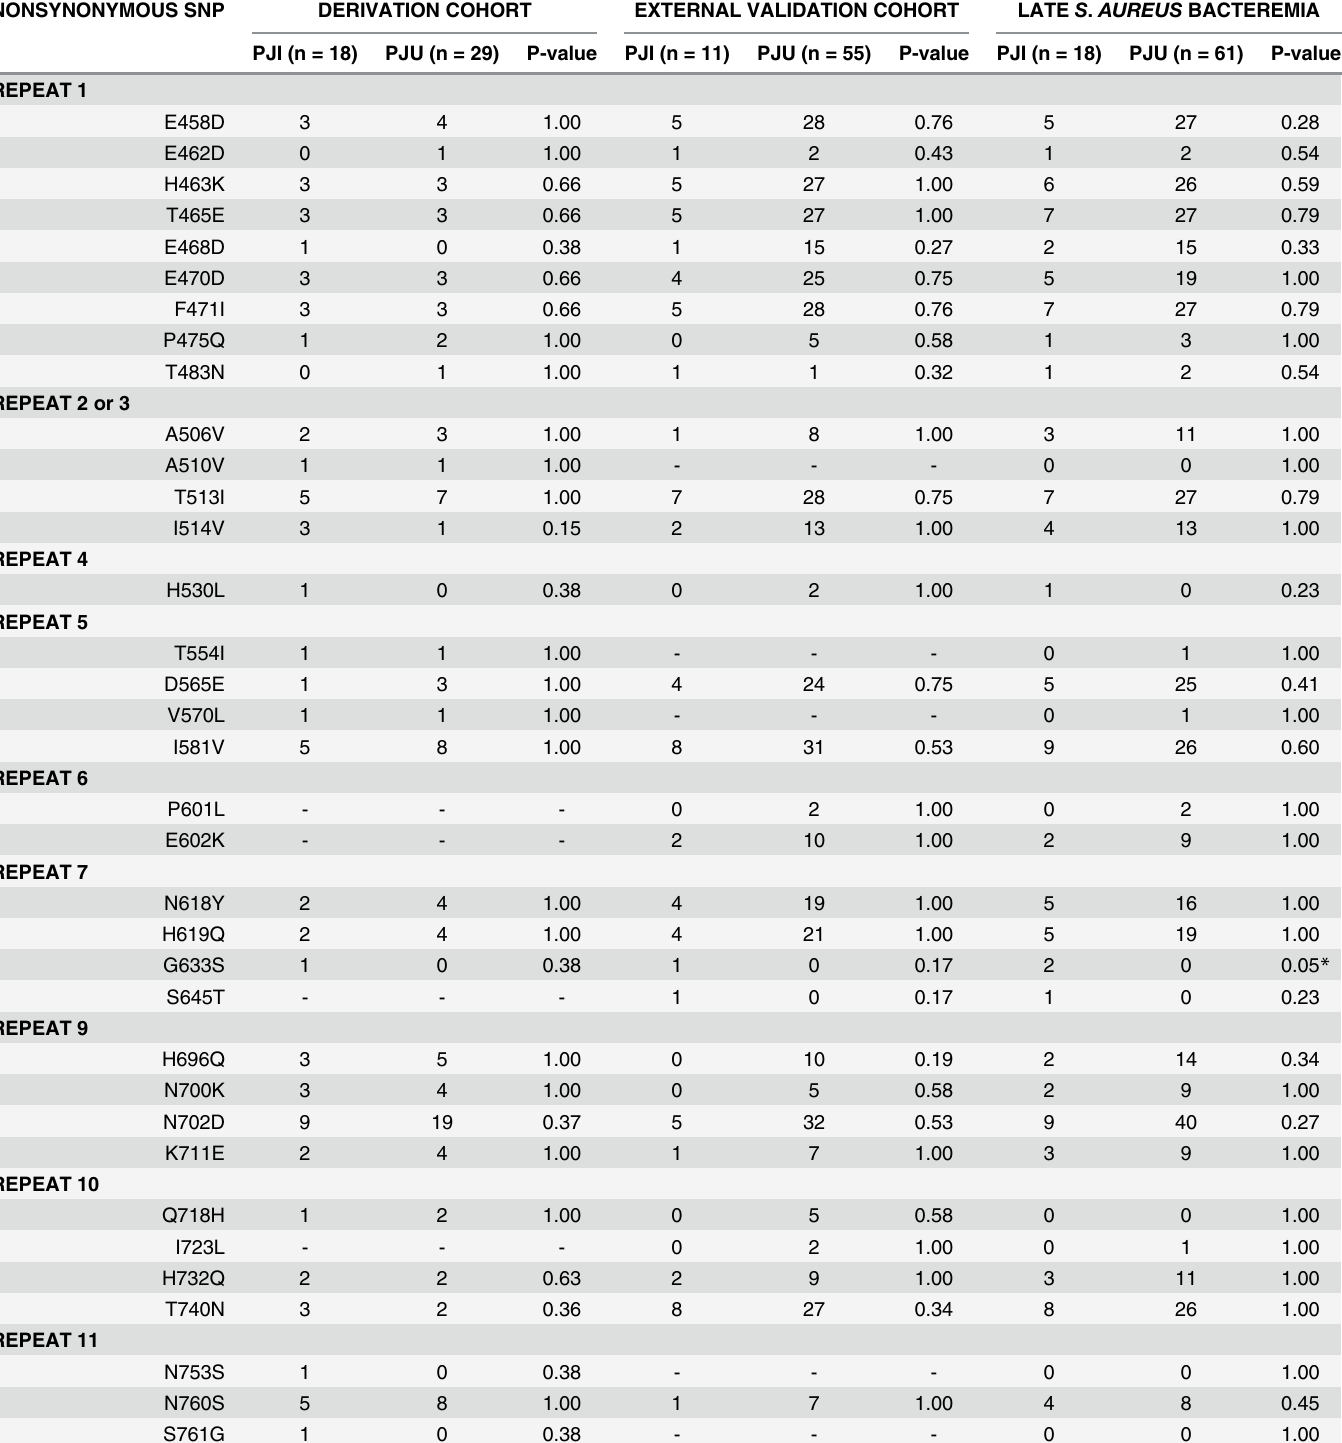
Table 3. Single Nucleotide Polymorphisms (SNPs) in fibronectin binding protein B ( fnbB) in fnbB- containing isolates. No SNP was associated with the prosthetic joint infected (PJI) or uninfected (PJU) isolates in the derivation cohort, external validation cohort, or late S . aureus bacteremia (SAB) group. Late SAB was defined as SAB occurring > 1 year after placement or manipulation of